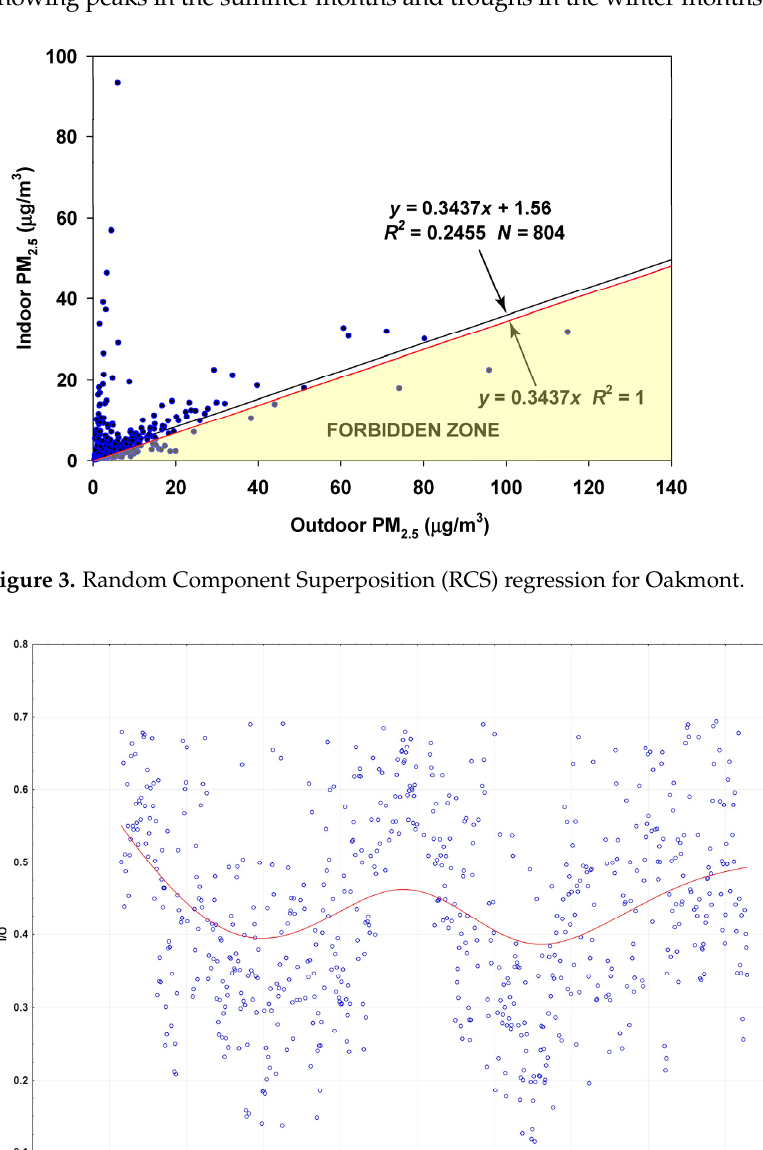
Figure 3. Random Component Superposition (RCS) regression for Oakmont.